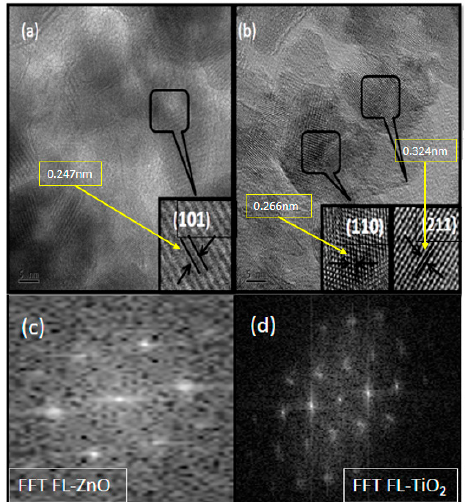
Figure 4. High-resolution transmission electron microscopy (HRTEM): ( a ) FL–ZnO, ( b ) FL–TiO 2 , ( c ) FFT FL–ZnO and ( d ) FFT FL–TiO 2 .